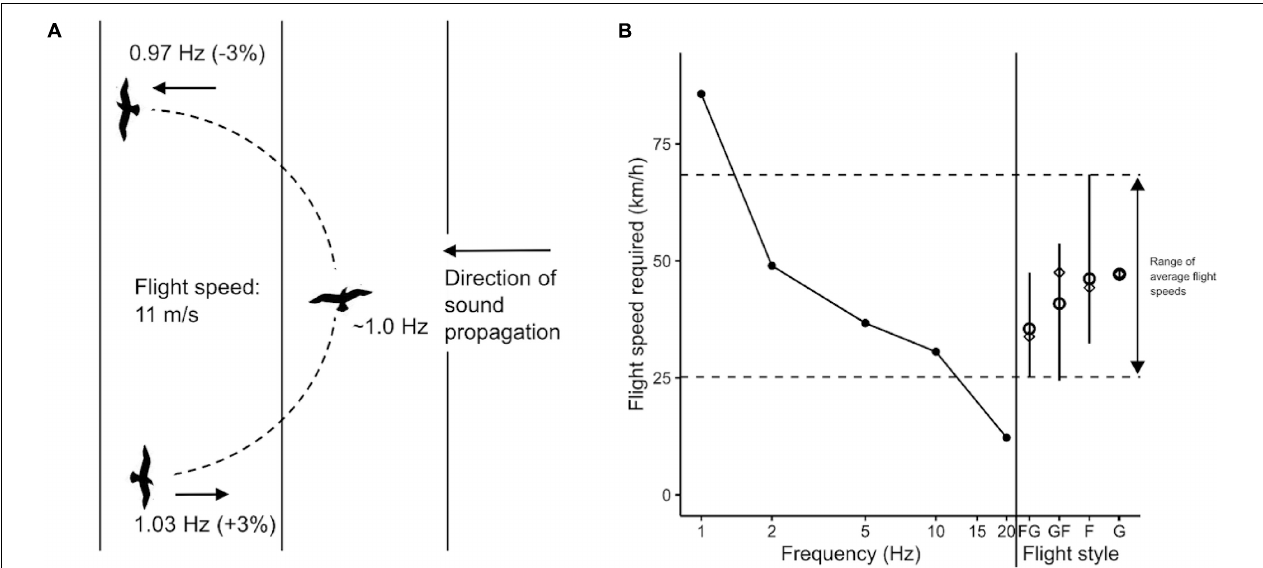
FIGURE 3 | Perception of direction through frequency shift caused by the Doppler effect during flight. (A) Given a stationary 1 Hz infrasound signal, a bird flying in the acoustic far-field at a ground speed of 40 km/h (11 m/s) toward or away from the source receives a frequency that is shifted up or down by 3% (i.e., to 1.03 or 0.97 Hz), relative to the frequency received by a stationary bird, or a bird flying perpendicularly to the signal. For indirect flight angles relative to the signal direction, the frequency shift will be less than ± 3%. Wavefronts of the propagating sound wave are indicated with vertical lines. (B) The range in average ground speeds of seabirds in crosswind flight (dashed lines) are compared to the estimated flight speeds that would be required to produce the frequency shift thresholds determined empirically in pigeons by Quine and Kreithen (1981) (black dots). To the right, average flight speeds are grouped by different flight styles (FG, flap-gliders; GF, glide-flappers; G, gliders; F, flappers), with means (dots), medians (diamonds), and range (lines). Data for average flight speeds are taken from Table 3 of Spear and Ainley (1997), with each flight group containing 2–11 mean flight speeds. These results suggest that seabird flight speeds could be sufficient to produce a detectable frequency shift (for details of calculations, see Supplementary Material Appendix 3